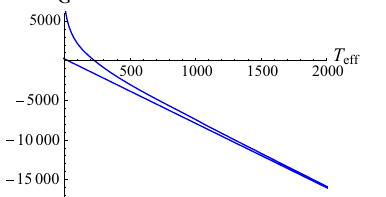
Fig. 6 G − T ef f diagram for n = 5 , k = 1 , m = 3 , c 1 = − 3 , c 2 = 1 , c 3 = 1 , c 4 = 1 , r c = 1 , q = 0 .